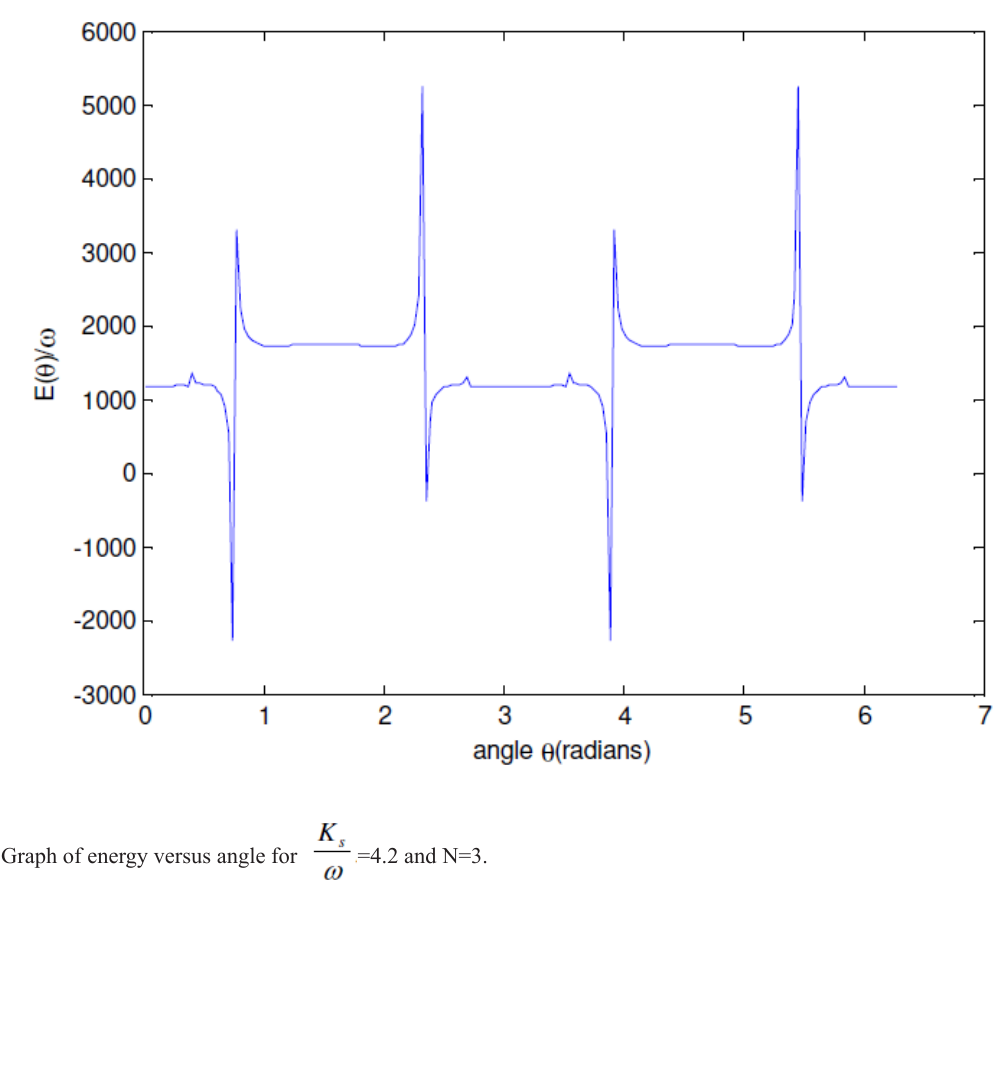
Figure 4: Graph of energy versus angle for =4.2 and